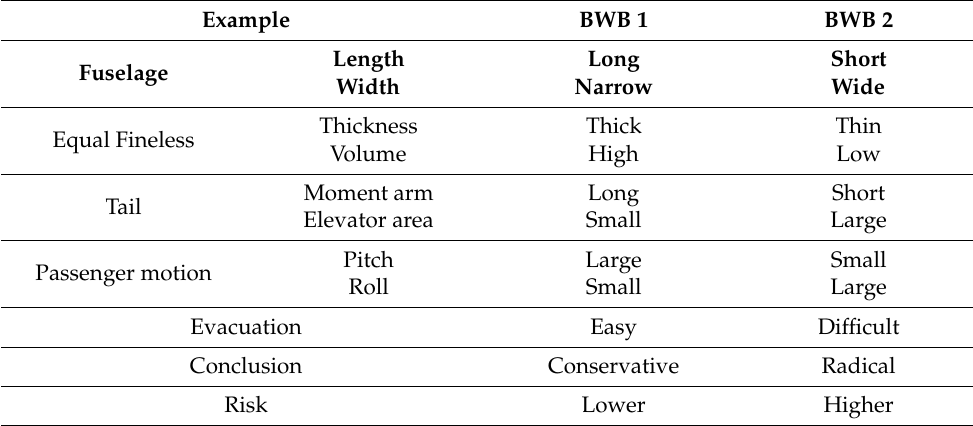
Table 14. Comparison of flying wing